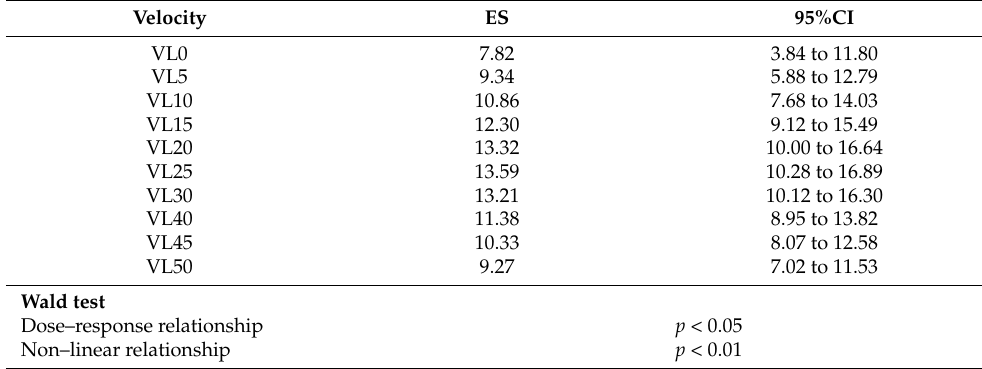
Figure 2. The dose–response curve of 1RM gain. Table 4. The dose–specific effects of velocity loss on maximum strength gain and the model fit.